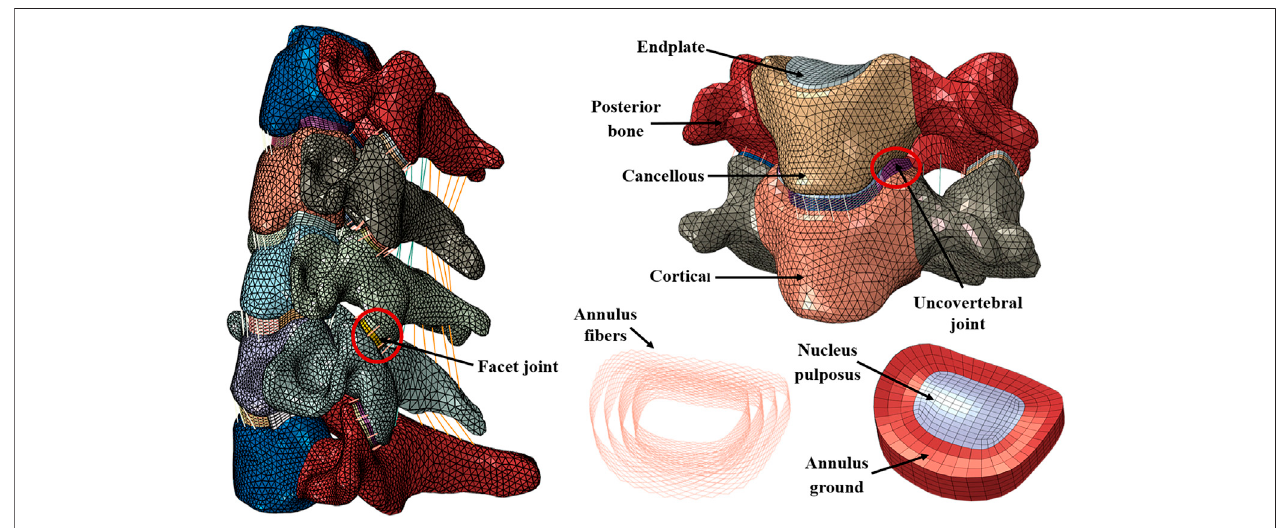
FIGURE 1 | Finite element model of intact C3 – C7 and